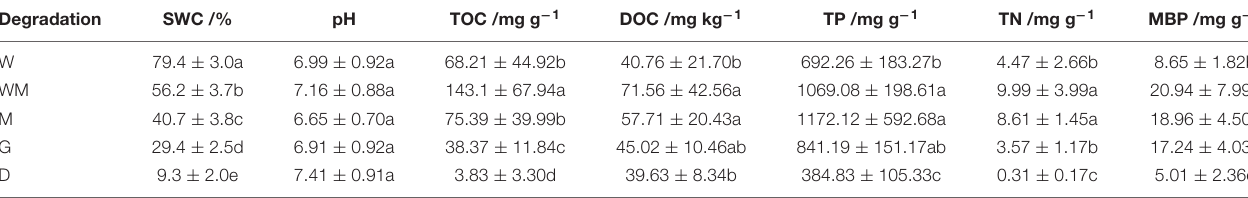
TABLE 1 | Soil basic properties along alpine wetland degradation gradients.